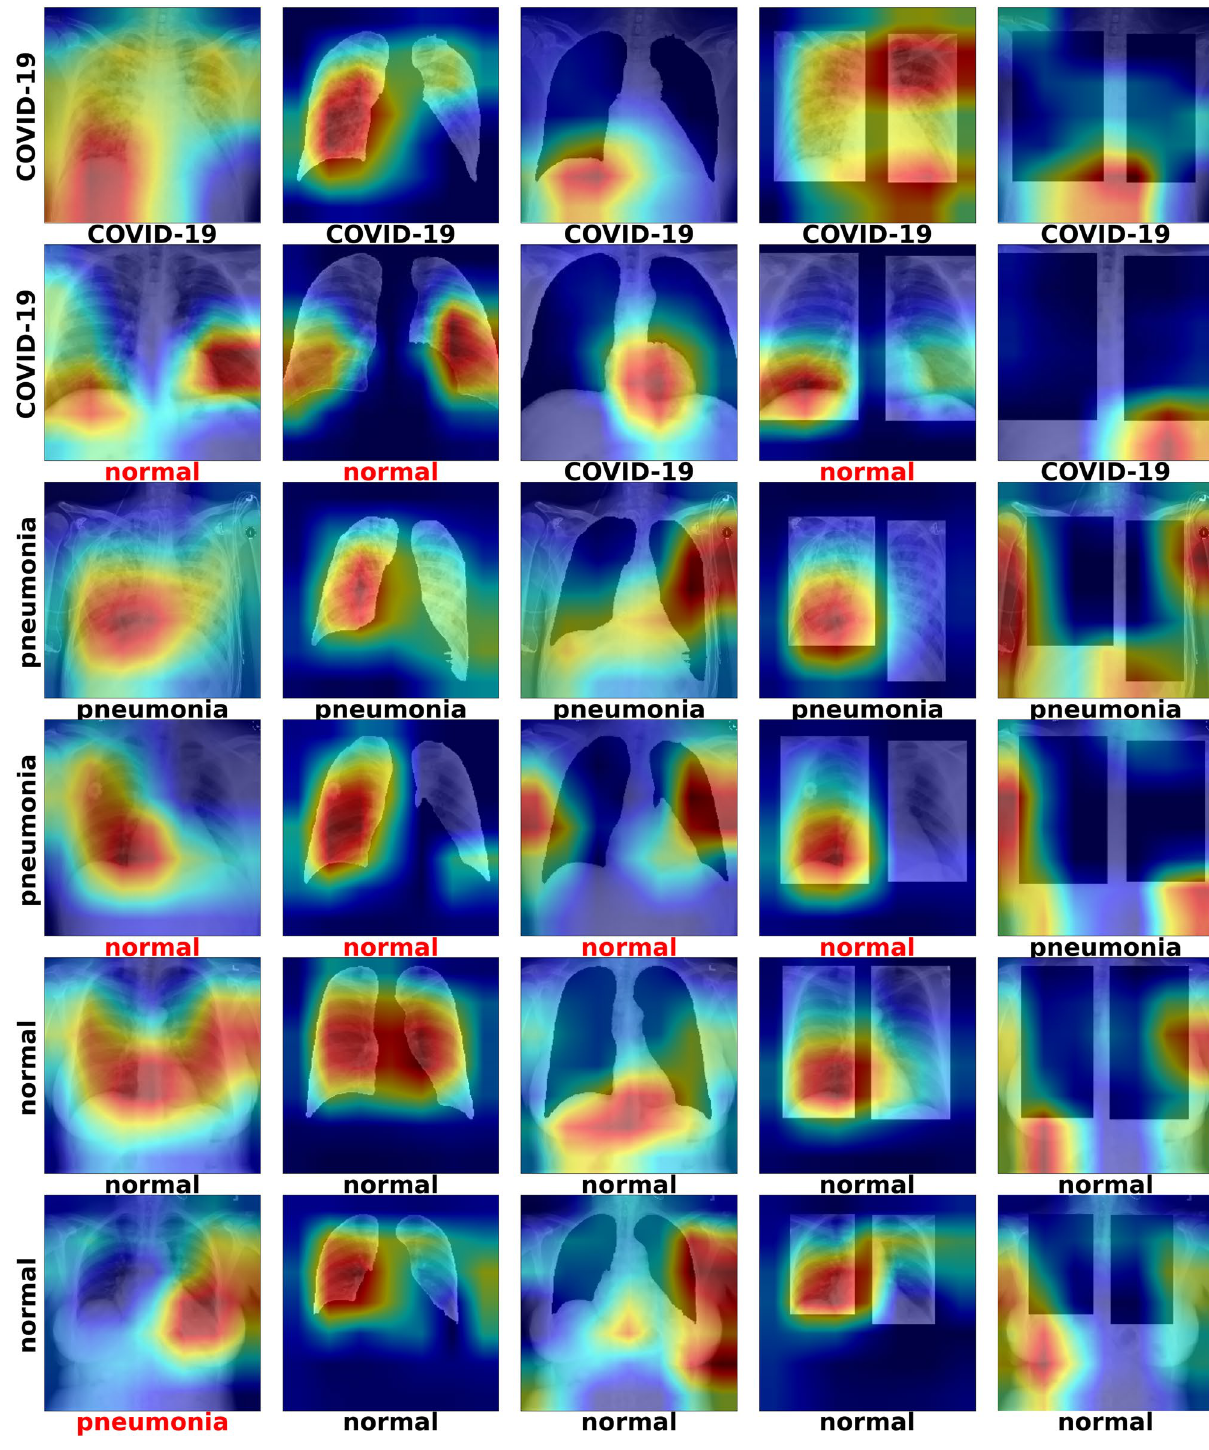
Figure 3. Grad-CAM of ResNet-50 models—the label on the left side of each row corresponds to the ground- truth label of that image (COVID-19, Pneumonia, Normal). Each image in each row corresponds to the Grad-CAM inference result on the different modified test sets (data, data_lungs_isolated, data_lungs_removed, data_lungs_framed, data_lungs_boxed_out). The label underneath the individual images corresponds to the classification label generated by the network corresponding to that modified version of the